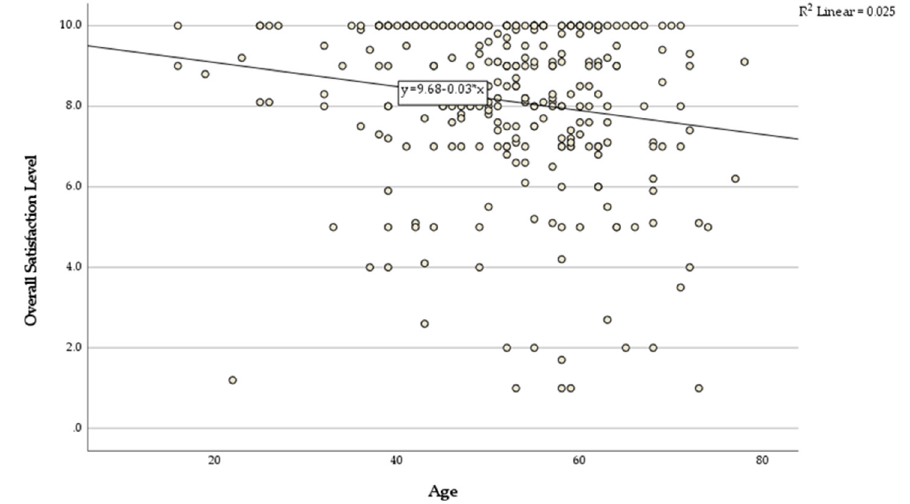
Figure 2. Linear regression results for overall satisfaction level and age. Respondents were asked to rate how satisfied they were with a set of eight environ- mental items in their most recent trip to Florida Keys National Marine Sanctuary (Table